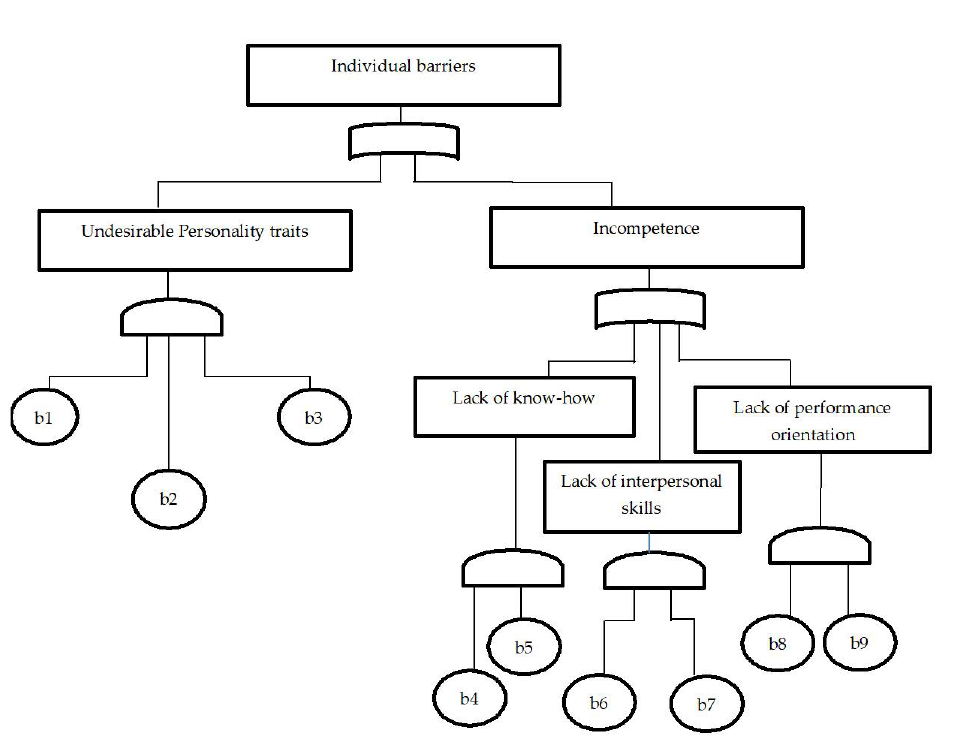
Figure 3. Independent fault tree analysis for probable causes due to individual barriers